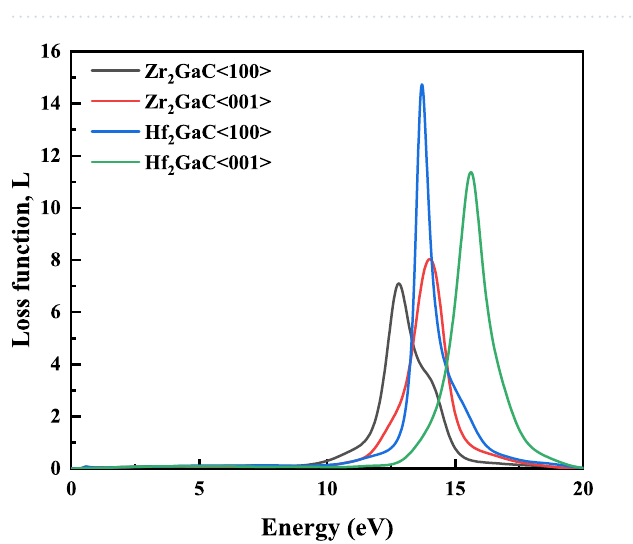
Figure 15. Energy dependence of dielectric function a real part b imaginary part of M 2 GaC MAX phase (M = Zr, Hf).